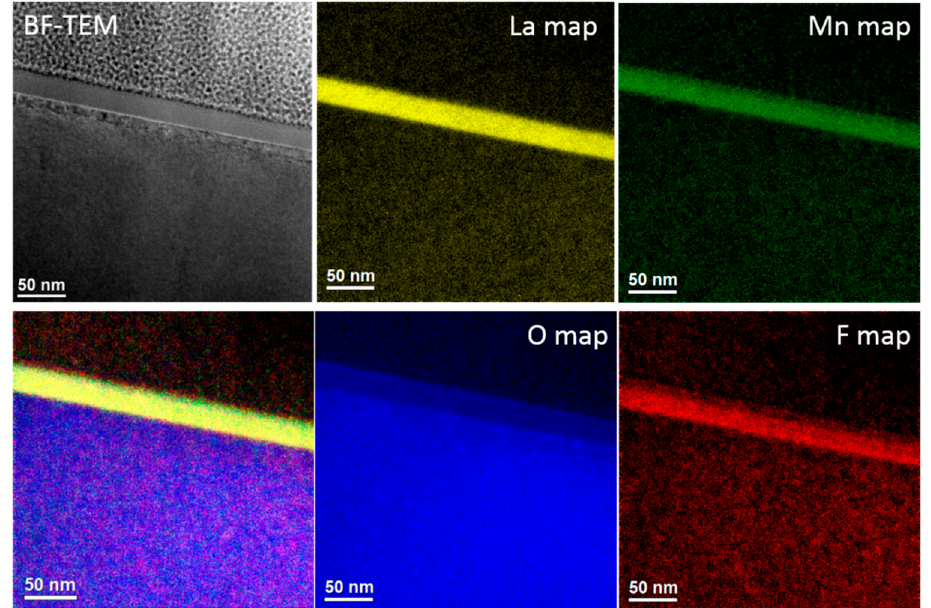
Figure 3. Energy filtered TEM elemental maps of the LSMO_F film showing fluorine incorporation into the LSMO layer.